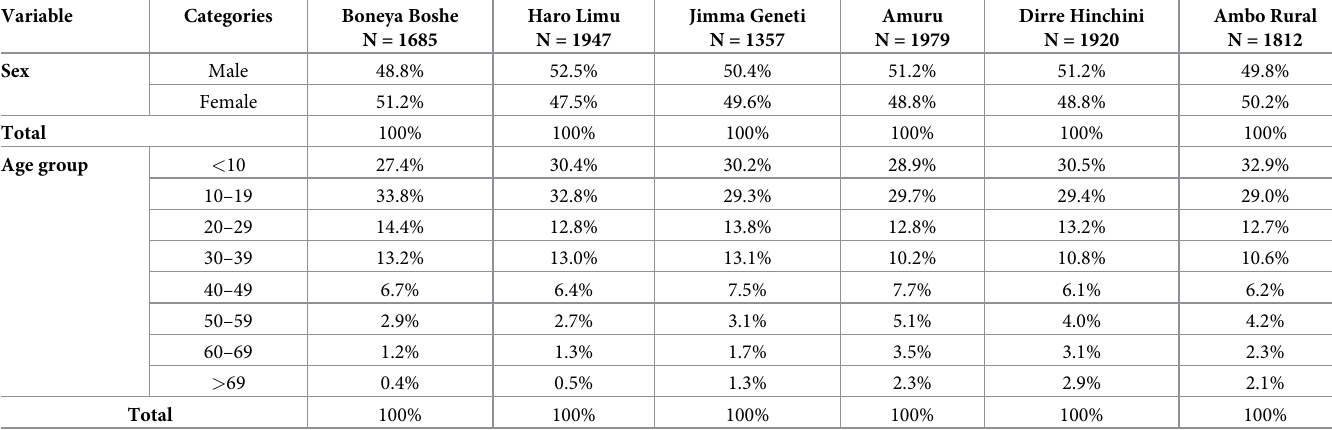
Table 6. Sex and age distribution of the interviewed population among East Wollega, Horo Guduru Wollega and West Shewa zones, 2017. Variable